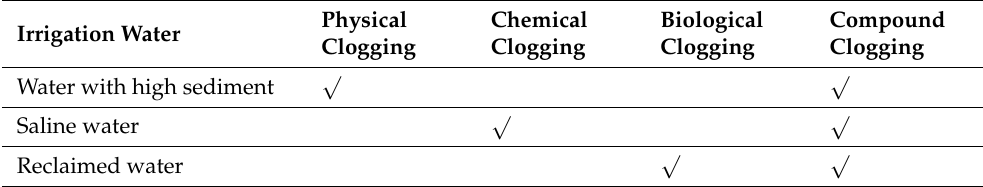
Table 4. The emitter clogging type for typical irrigation